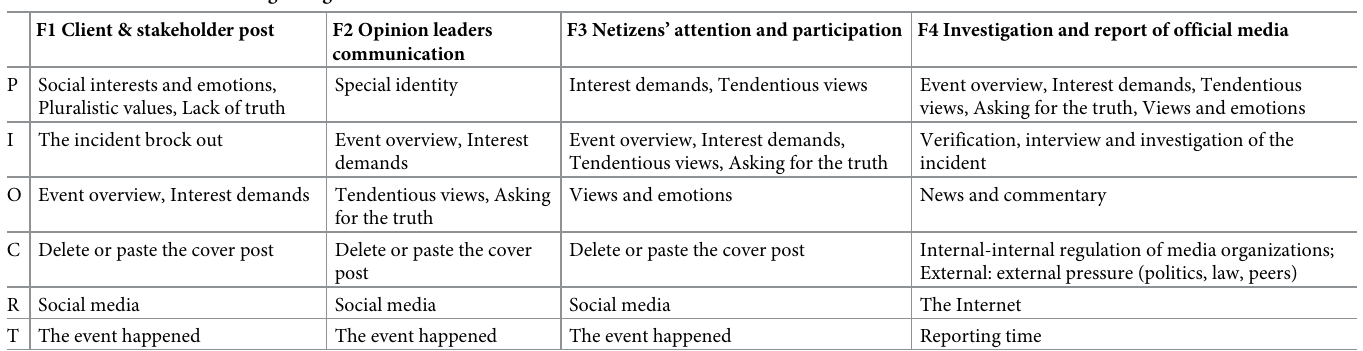
Table 1. The functions in the beginning.